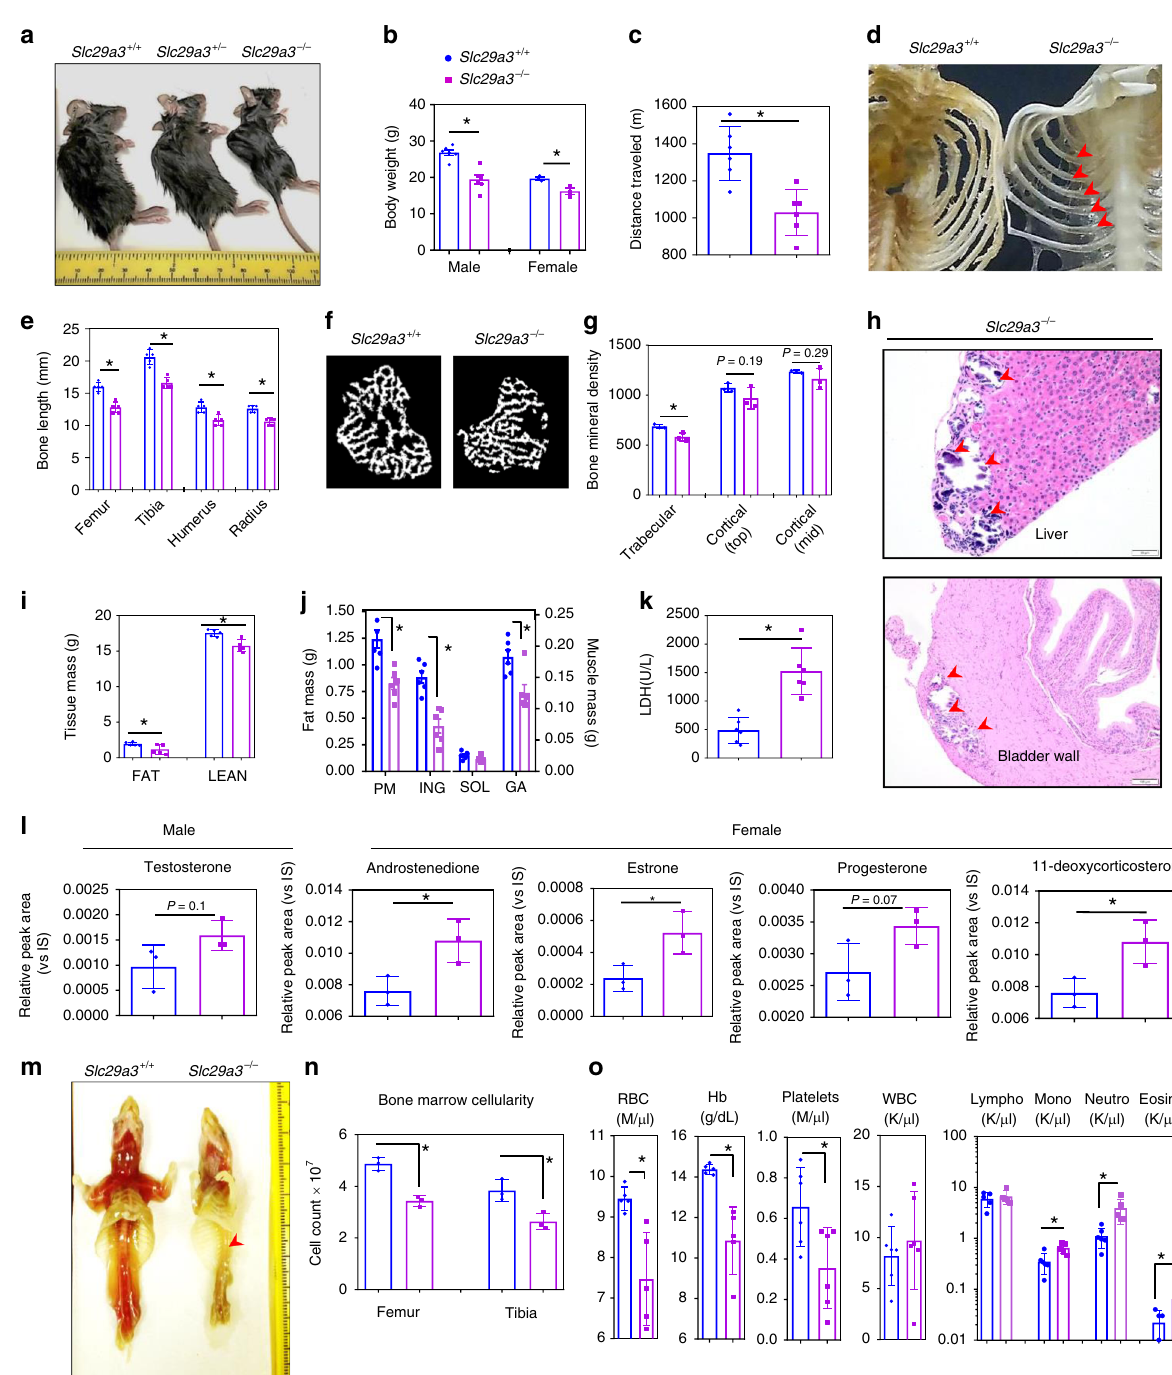
HSC markers (Fig. 3d and Supplementary Fig. 3b) also indicated the loss of HSC clonogenicity. Consistently, Slc29a3 − / − MSCs and HSCs showed decreased expression of genes (Fig. 3e) essential to maintain multipotentiality 29,30 . In vivo analysis of bone marrow revealed an apparent loss of stem cells beginning at ~12 weeks that reached a classical state of stem cell exhaustion at ~16 weeks (Fig. 3f and Supplementary Fig. 4a). To test whether the lack of ENT3 is a mechanism underlying the exhaustion of bone marrow stem cell populations, we examined the ability of WT and Slc29a3 − / − HSCs for hematopoietic reconstitution in a uniform C57BL6/J-congenic 129S5/SvEvBrd mouse line.